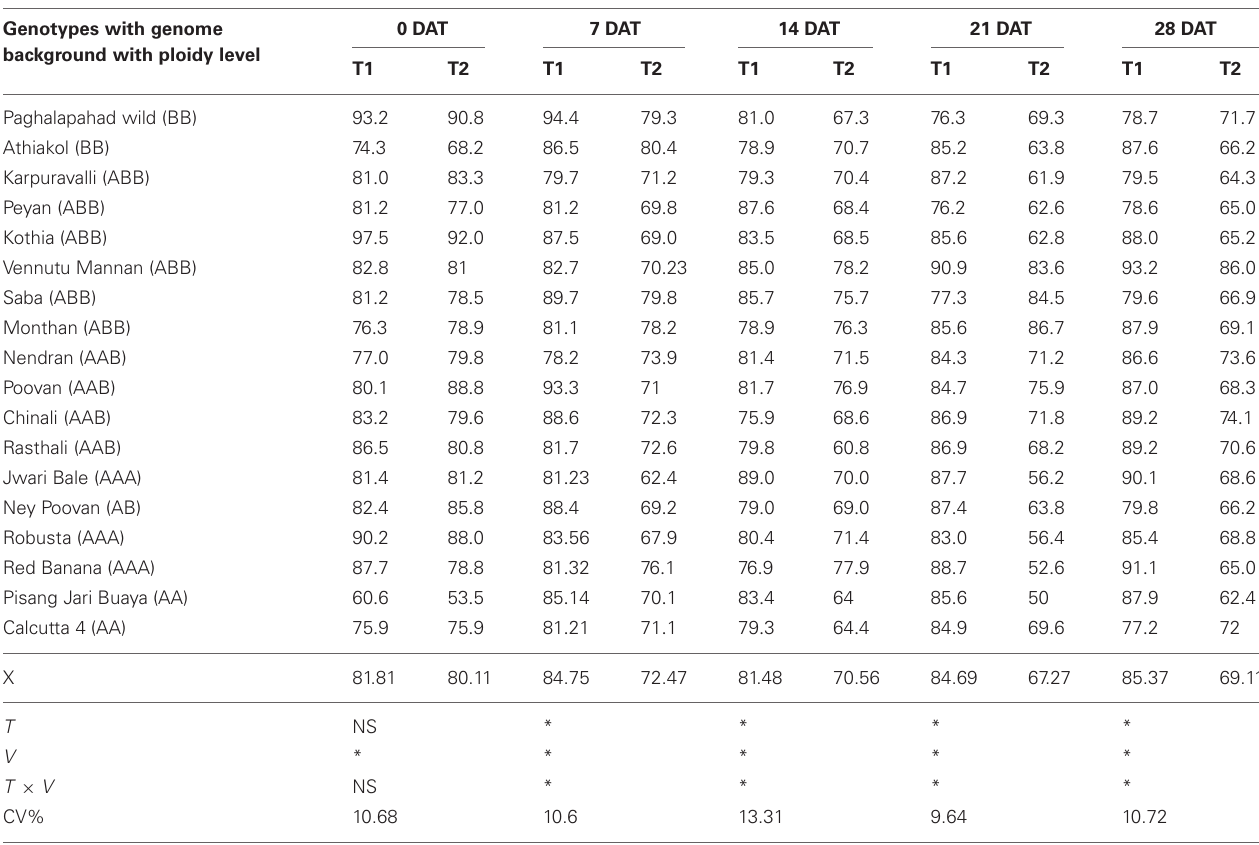
Table 2 | Relative water content (RWC) of drought stressed banana genotypes. Genotypes with genome background with ploidy